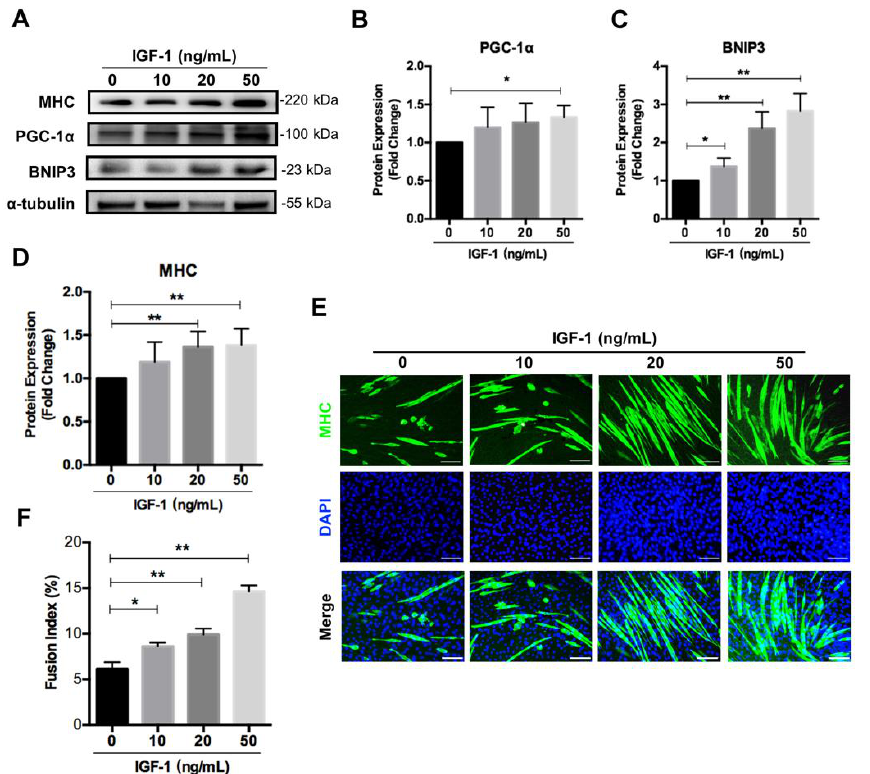
Figure 5. IGF-1 induces PGC-1 α and BNIP3 accumulation dose-dependently. ( A – D ) Representative immunoblots and quantitative analysis of PGC-1 α ( B ), BNIP3 ( C ), MHC ( D ), and α -tubulin in C2C12 cells after 5 days of differentiation. ( E ) Immunofluorescent staining of MHC (green) and DAPI (blue) of the fusion index in C2C12 cells treated with 0~50 ng/mL of IGF-1 after 5 days of differentiation. ( F ) Quantitative analysis of the fusion index. Scale bar = 100 μm. Data represent means ± SD. * p < 0.05 and ** p < 0.01.